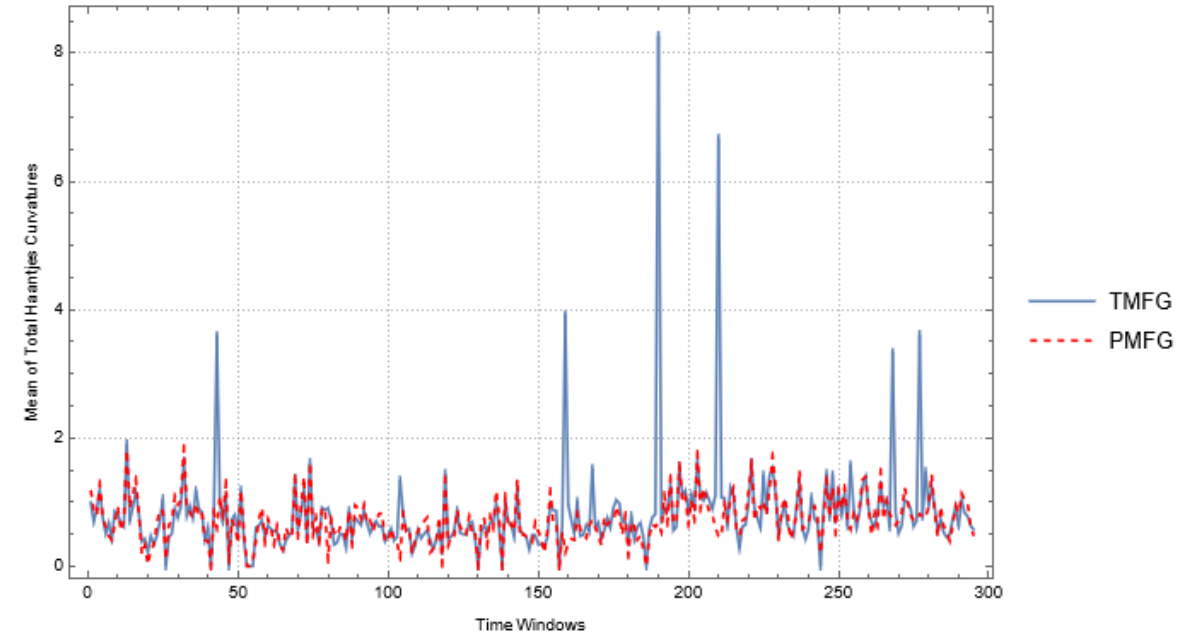
for FTSE100 using TMFG and PMFG filtrations. T